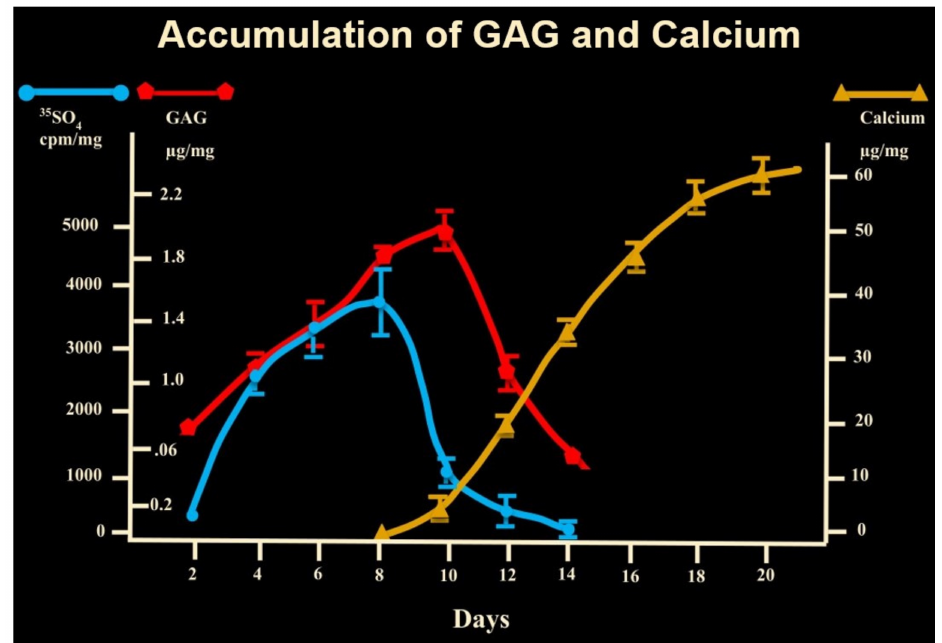
Figure 7. Coordinated proteoglycan and glycosaminoglycan reduction with the onset of calcifica- tion. As is typical of physiologic examples of endochondral bone formation, chondrogenesis ceases and chondroid matrix is removed with the onset of calcification. This biphasic process leads to ossification